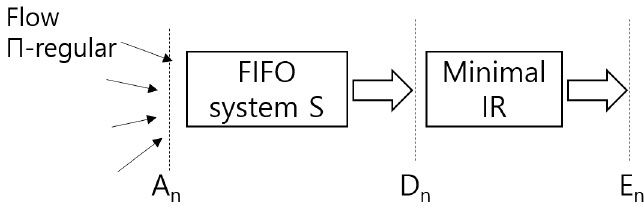
Figure 1. Combined system of a FIFO system and a minimal interleaved regulator (IR).